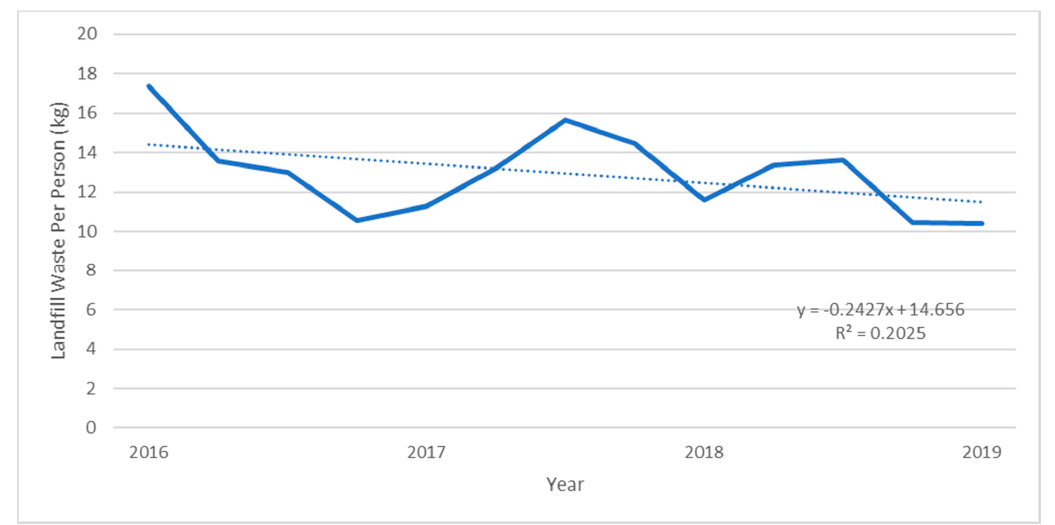
Figure 4. Total landfilled waste per person (kg) per quarter; Welsh Average. Source: WasteDataFlow and StatsWales. Dotted line shows trend line represented also in figure by regression equation and coefficient of determination (R 2 ).